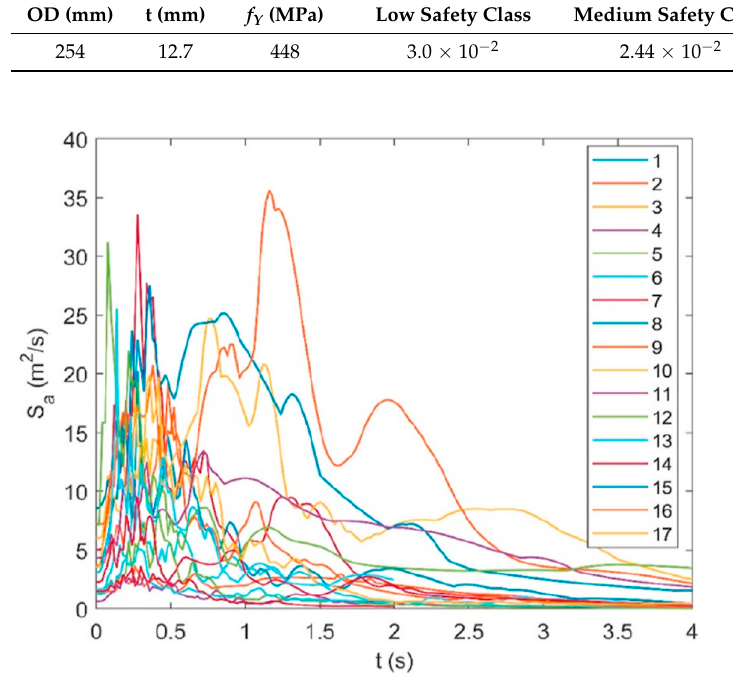
Figure 4. Seismic scenarios. Table 3. Failure criteria for different safety classes.